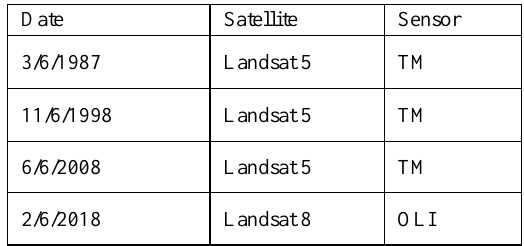
Figure 1. The location of the study area (Wad Alabas village). Data used to map the village expansion for the period (1987- 2018) were Landsat satellite images downloaded from the United States Geological Survey (USGS) Earth Explorer website (https://earthexplorer.usgs.gov/). The selection of the images is based on availability, a span of a 10-year period, and be cloud- free (Table 1). In order to quantify the built-up areas accurately, Google Earth data were used to exclude non-built-up areas inside the village boundary. Furthermore, the historical data from Google Earth were used to evaluate the built-up areas extracted from image processing.